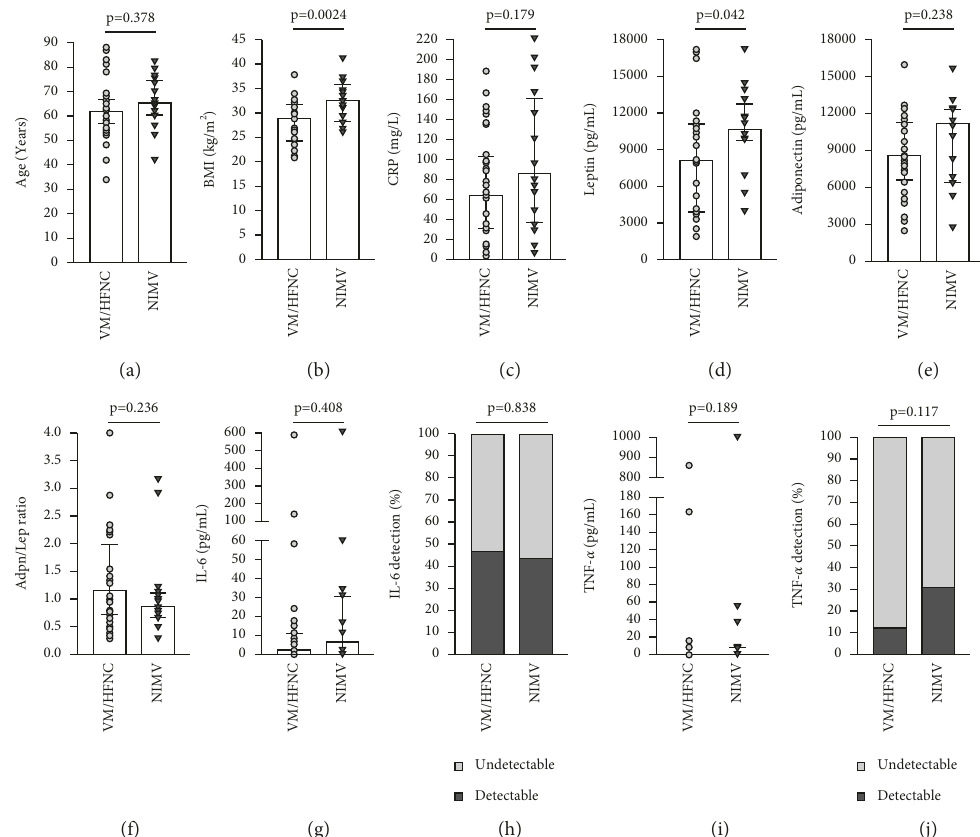
Figure 3: Factors associated with maximum respiratory support given. Mann–Whitney test or t -test (a–g), (i), and chi-square test (h, j).